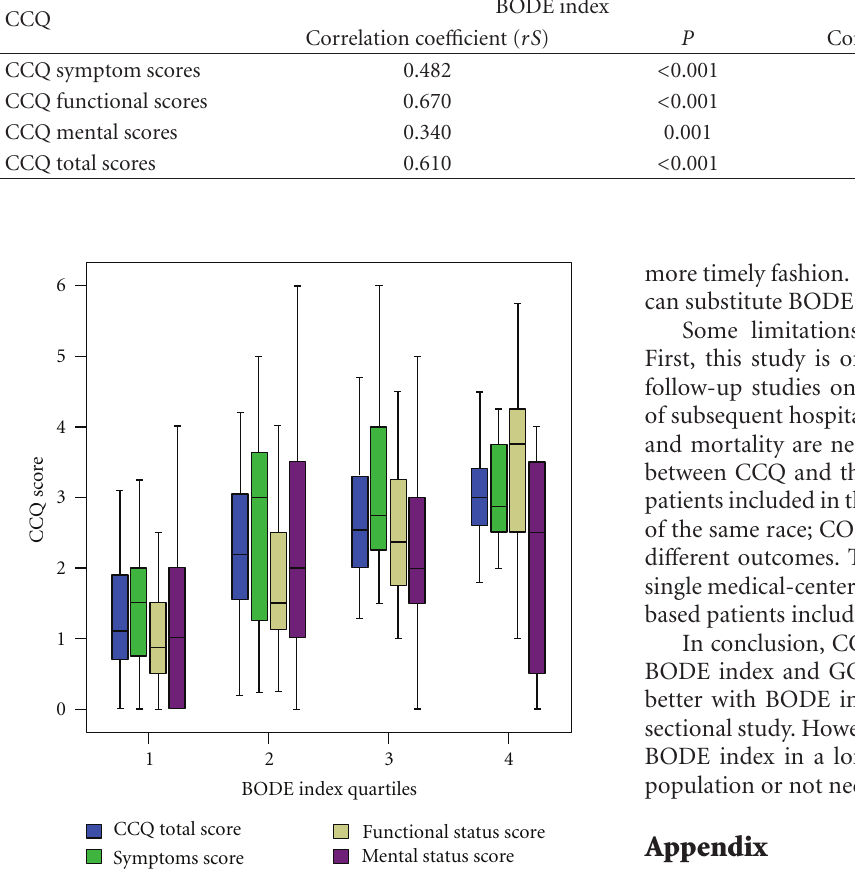
Figure 2: Box plot for CCQ scores by BODE quartiles. Error bars show standard deviation and horizontal lines within boxes show the mean for CCQ